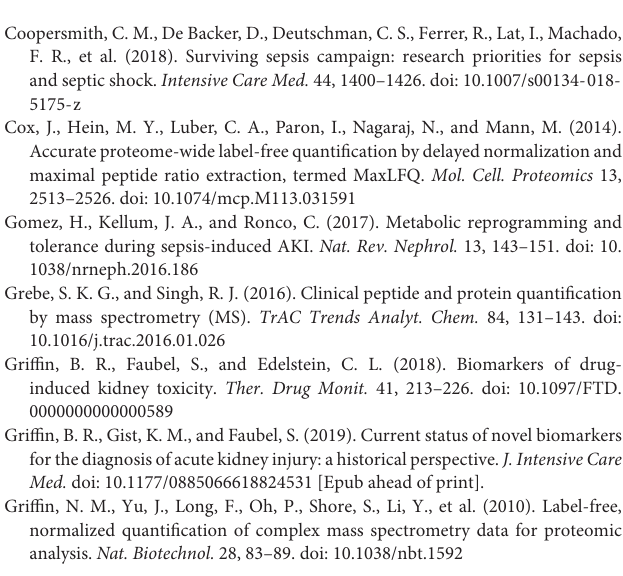
FIGURE S1 | Analysis of data distribution and quantitative abundance. (A) Analysis of data distribution. The histogram represents the data distribution of each sample. Experimental data basically conformed to the normal distribution, which could be used for subsequent statistical analysis. (B) Analysis of the quantitative abundance of protein. The abscissa represents the sample name, and the ordinate represents the protein classification (normalized results). Each point in the figure represents the abundance value of a protein. A polyvine diagram was formed by connecting the points. The black box in the middle was the boxplot of the protein abundance of each sample. The orange polyline represents the abundance distribution trend of the protein P3052 in different samples. FIGURES S2–S4 | The biological process, cell components, and molecular function of differentially expressed proteins in which differentially expressed proteins in urine at the indicated time (3, 6, 12, 24, and 48 h) were compared with those at 0 h. P < 0.05.